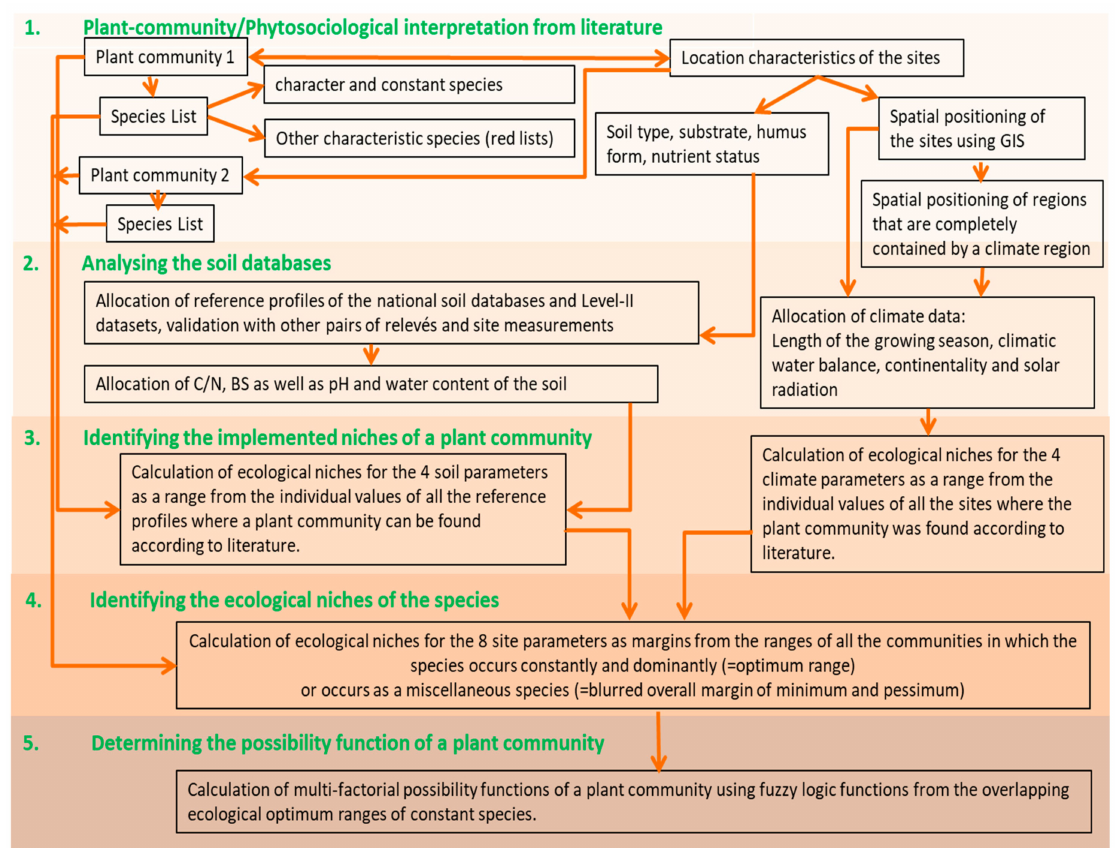
Figure 3. Flowchart for the generation of the BERN database and the modelling of the possibility function for the existence of plant communities on this basis—authors’ own